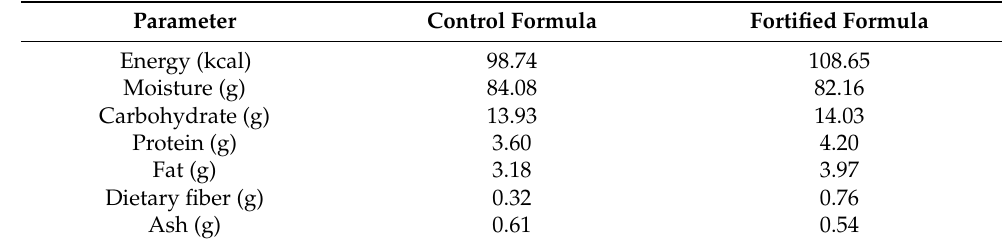
Table 2. Comparison of energy and macro-nutrients in the control and fortified complete nutrition formulas after retort sterilization.